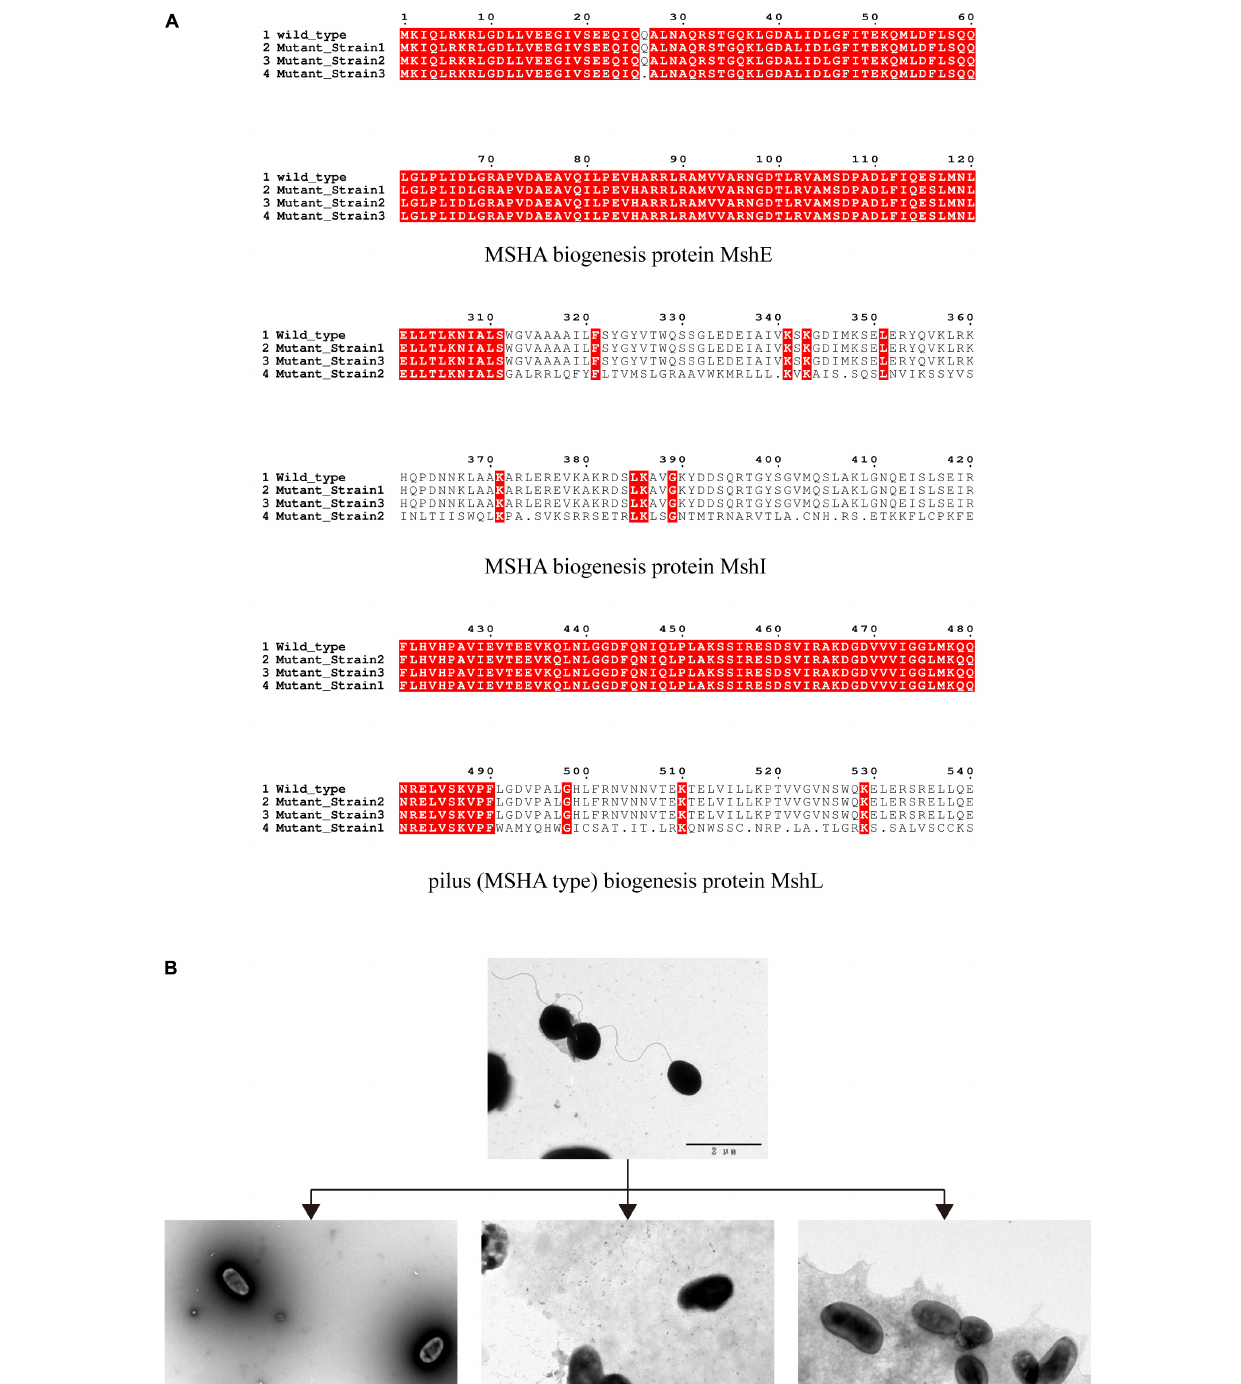
Frontiers in Microbiology |